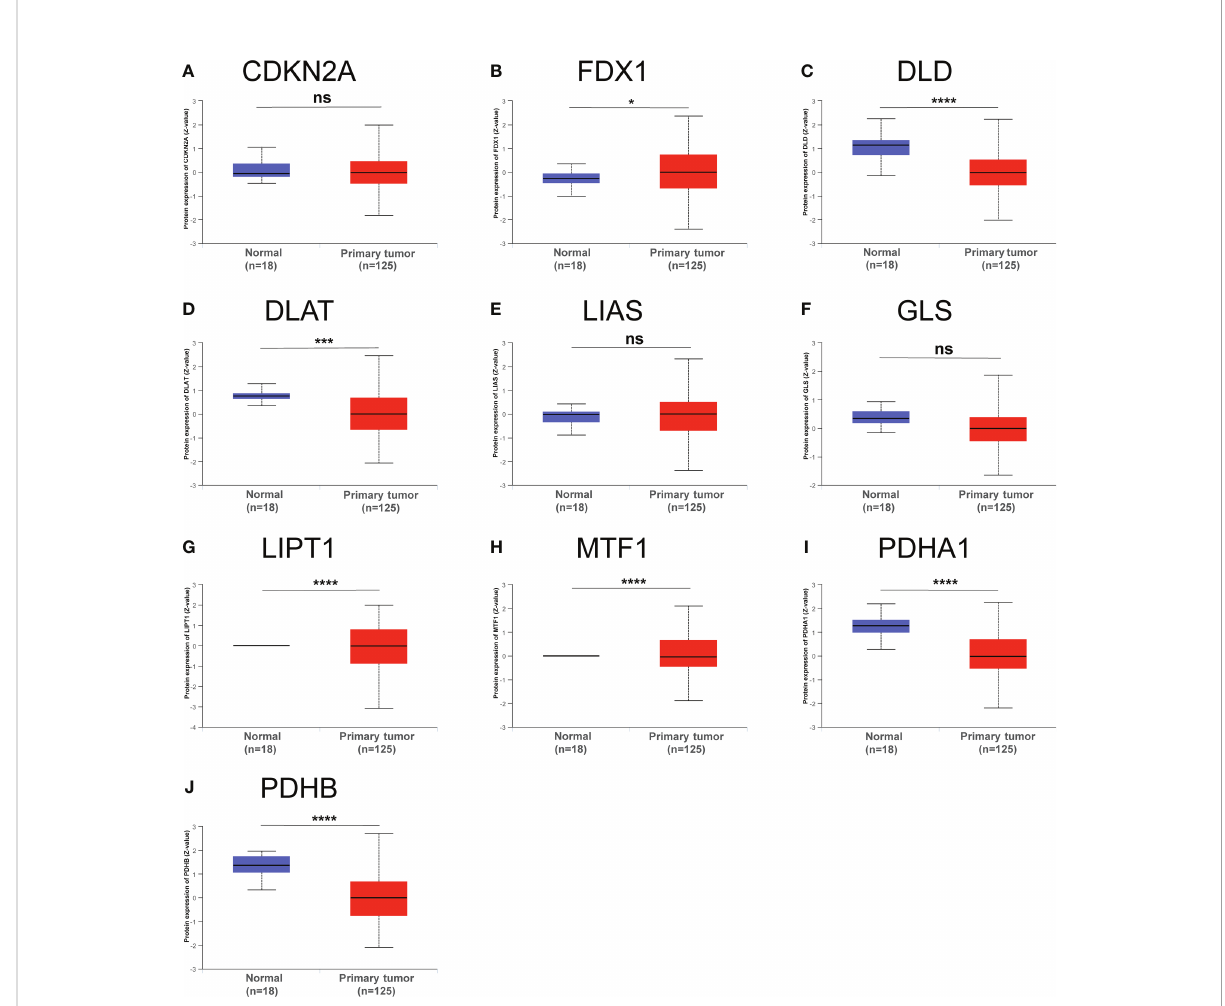
FIGURE 3 Total protein levels of CRGs (A – J) in normal tissue and BC. Protein expresssion data was collected and analyzed using CPTAC. *p < 0.05, ***P < 0.001, ****P < 0.0001; ns, no statistically signi fi